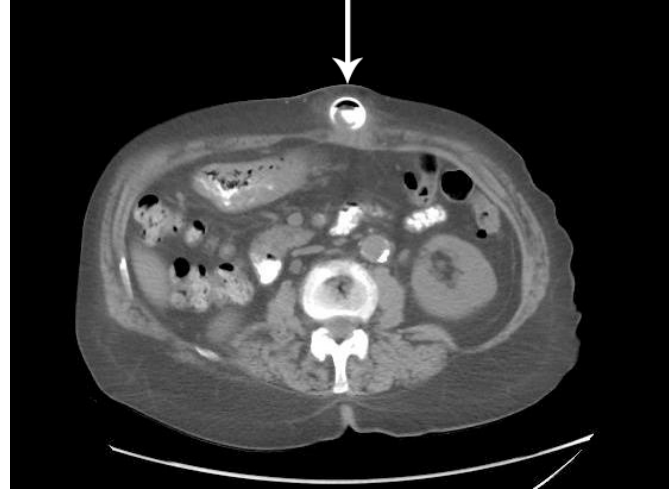
Figure . Axial contrast computed tomography demonstrates internal bolster in the subcutaneous tissue of the anterior abdominal wall without evidence of contrast